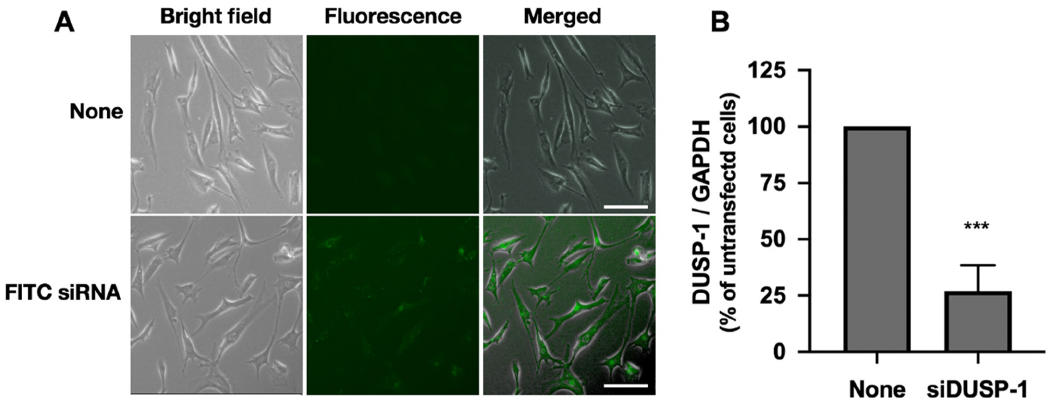
Figure 3. Effects of PGE 2 and PGE 1 on DUSP-1 expression in human IVD cells. ( A ) Confluent human IVD cells were serum starved, and then left untreated (circles), treated with PGE 2 (1 μ M) (squares), or treated with PGE 1 (triangles) for 0.5, 1, and 3 h. Relative amounts of DUSP-1 were quantified by real-time PCR. Results are shown as the mean ± SD (n = 4 individuals) of DUSP-1 after normalization to GAPDH, and expressed as a relative value to that of untreated cells at each time point. * p < 0.05, ** p < 0.01, and *** p < 0.001 between untreated and PGE 2 - or PGE 1 -treated cells at each time point. ( B ) Confluent human IVD cells were serum starved, left untreated (black column), preincubated with PGE 2 (light gray column), or preincubated with PGE 1 (dark gray column) for 3 h (1, 10, or 100 µ M), and then stimulated with IL-1 β (10 ng/mL) for a further 6 h. Relative amounts of DUSP-1 were quantified by real-time PCR. Results are expressed as the mean ± SD ( n = 4 individuals) of DUSP-1 after normalization to GAPDH, and expressed as a relative value to that of untreated cells at each time point. ** p < 0.01 and *** p < 0.001 between untreated and PGE 2 or PGE 1 treated cells at each time point.